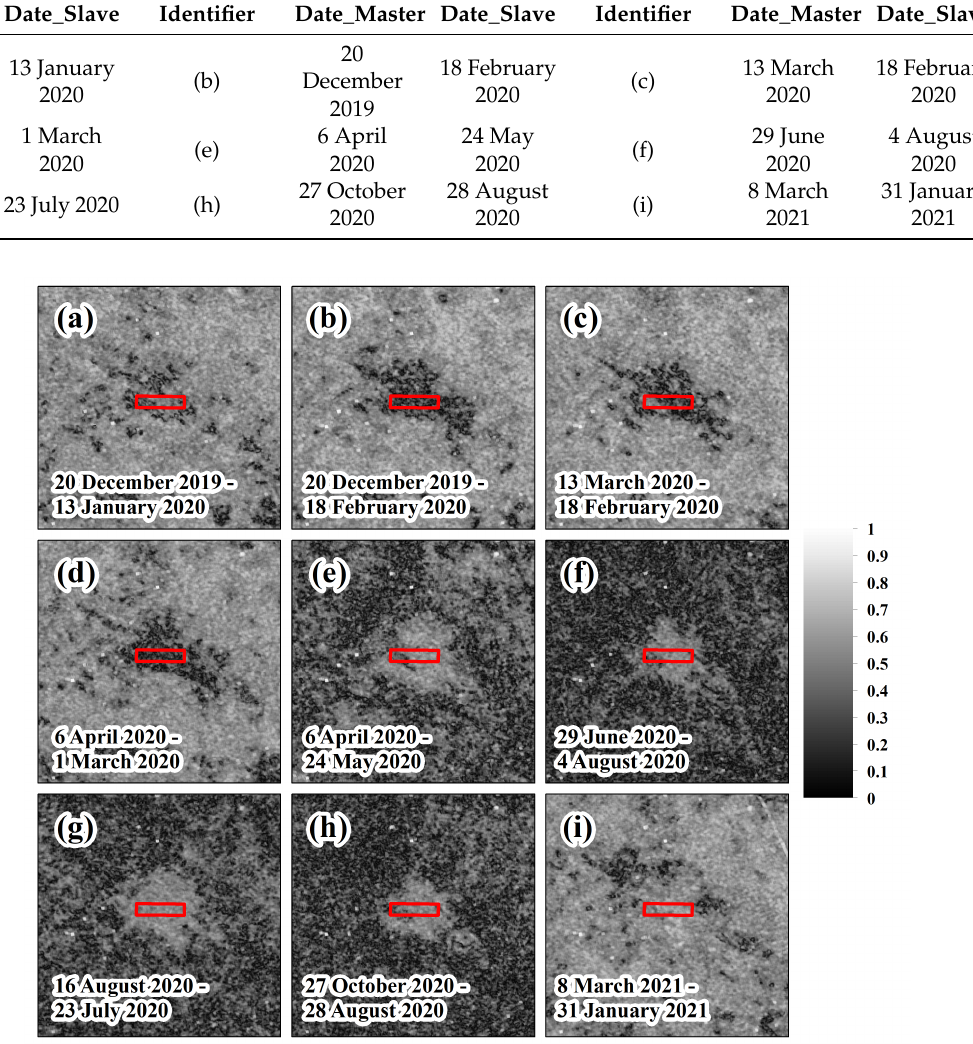
Table 3. Identification number and date of partial image pairs.